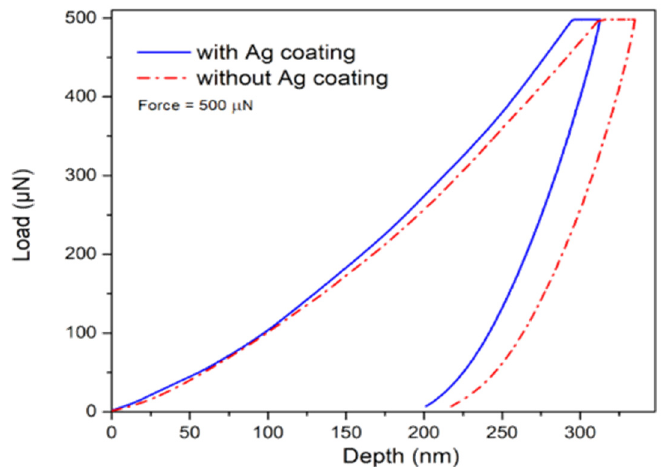
Figure 13. Force vs. displacement depth profiles for the virgin and Ag-coated pellets under force of 500 µ N for 5 seconds.